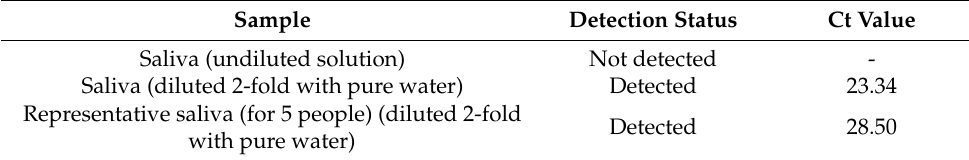
Table 3. qPCR results when using saliva mixed with RNase P synthetic RNA as a sample.